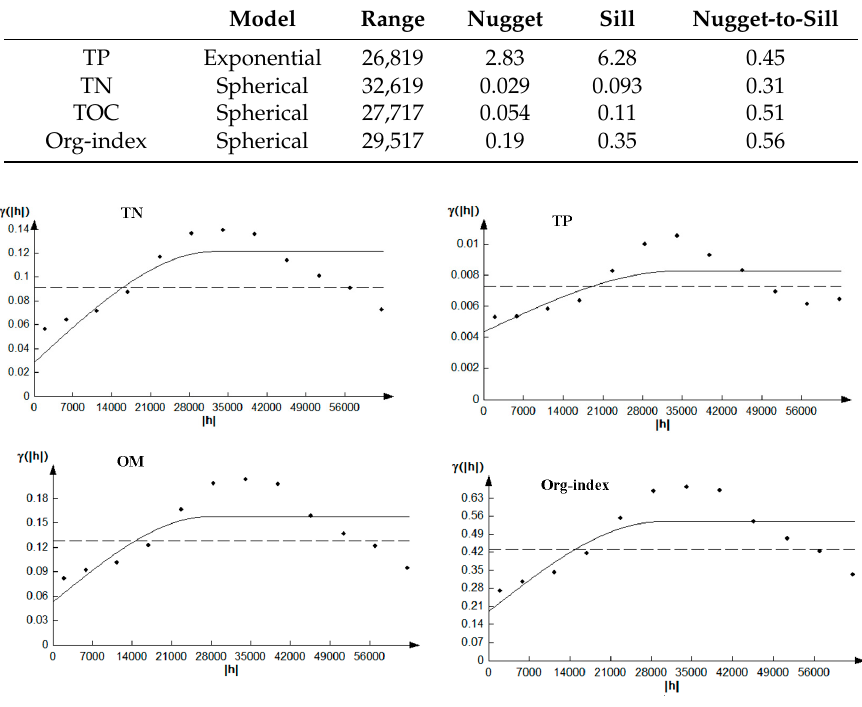
Table 2. Parameters of semivariagram models for studied variables.